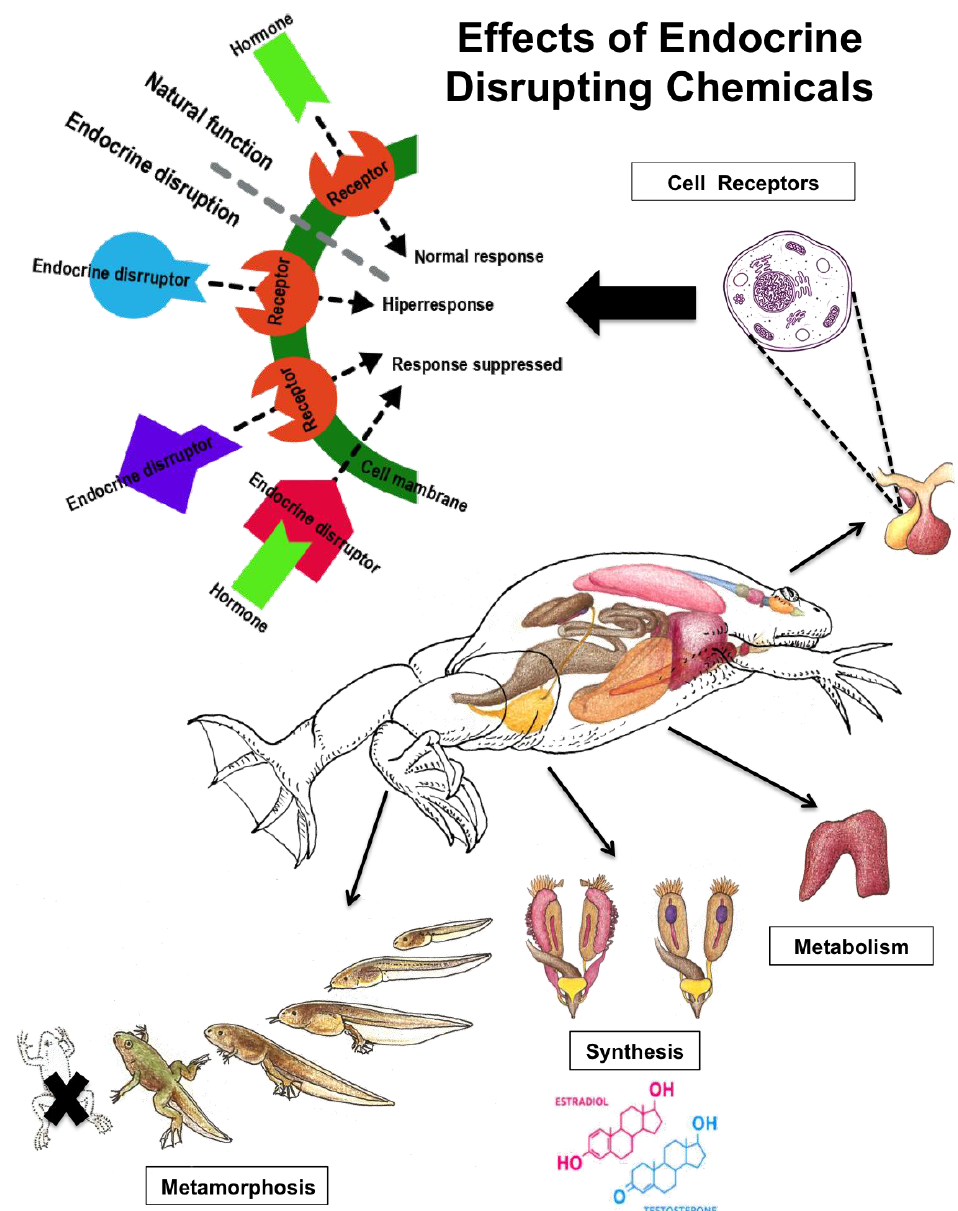
Figure 1. Effects of endocrine disrupting chemicals for vertebrates . Own production figure.